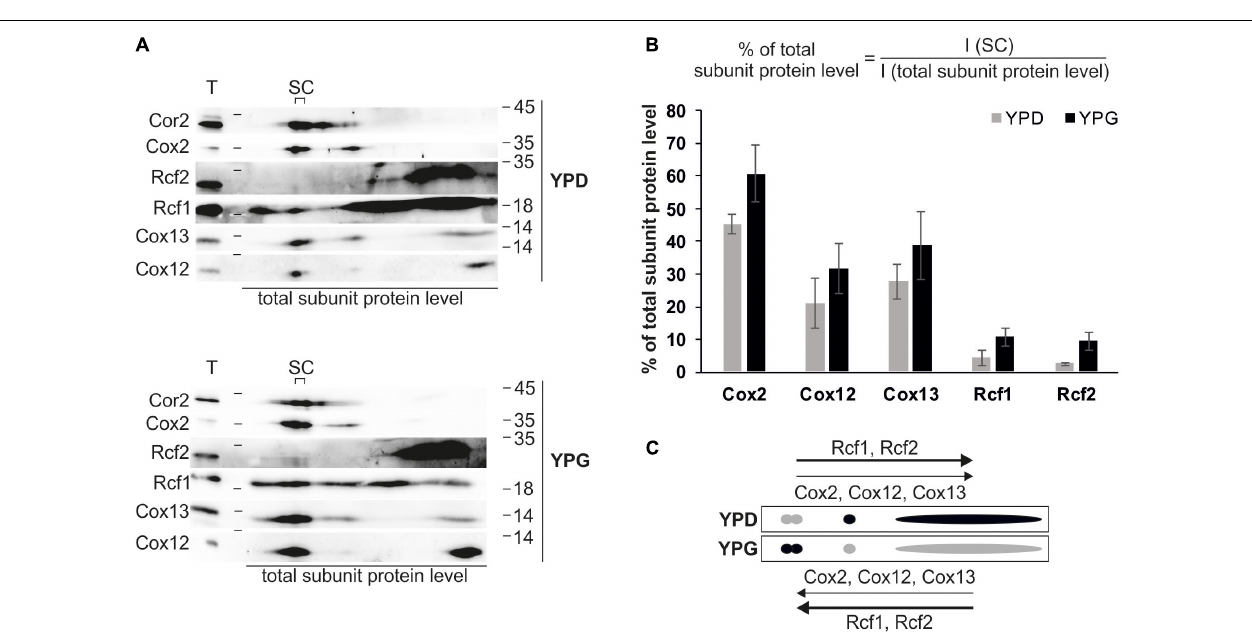
FIGURE 4 | Rcf1 and Rcf2 associate with supercomplexes depending on working load of respiratory chain. (A) Mitochondria isolated from cells grown in fermentable (YPD) or non-fermentable medium (YPG) were solubilized in 2% digitonin, separated using BN-PAGE followed by 2D SDS-PAGE, Western blot and immuno decoration. (B) Based on the 2D analysis, the amount of the respective subunit of cytochrome c oxidase or the amount of the proteins Rcf1 and Rcf2 residing in the supercomplexes was calculated in respect to the total subunit amount. While the cytochrome c oxidase subunits slightly shift into the supercomplexes (fold change of ∼ 1.4), Rcf1 and Rcf2 shift strongly into supercomplexes ( ∼ 2.5 and ∼ 3.7, respectively). The Western blot signals were analyzed using the software OriginPro (the standard errors were calculated from a sample size of n = 3). (C) Model of protein distribution due to different carbon sources. Under fermentable conditions (YPD) cytochrome c oxidase subunits (Cox2, Cox12, and Cox13) are shifted to the monomeric complex or a free form while under respiratory conditions (YPG) cytochrome c oxidase shifts into supercomplexes. Rcf1 and Rcf2 follow the trend but in a higher amount. T, total; SC, supercomplexes; I, intensity of developed western